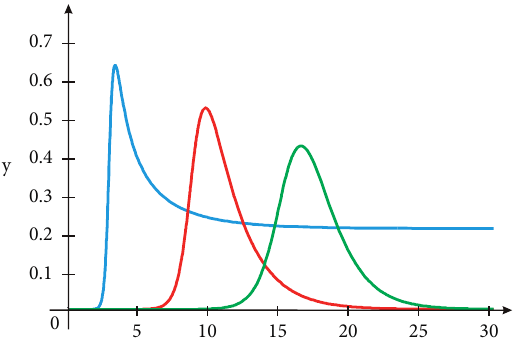
Figure 6: Evolution of y ( t ) for the fixed parameters β ′ � 0 . 532, δ � 0 . 071, and σ � 0 . 17. α � 0 . 0001, blue line; α � 0 . 1, red line; and α � 0 . 17, green line.